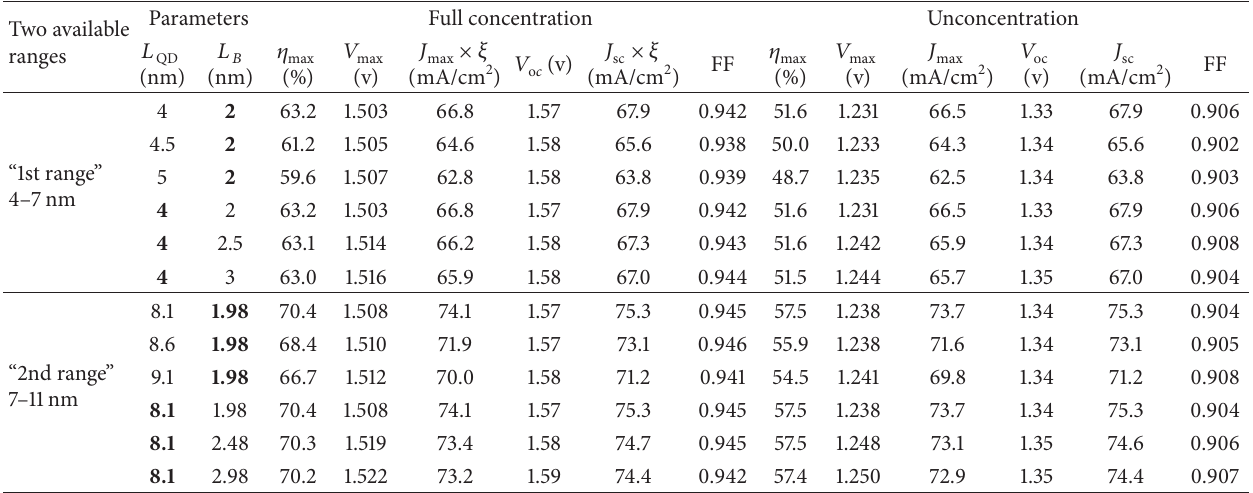
N ) and barrier width (GaAs 0.9 0.1